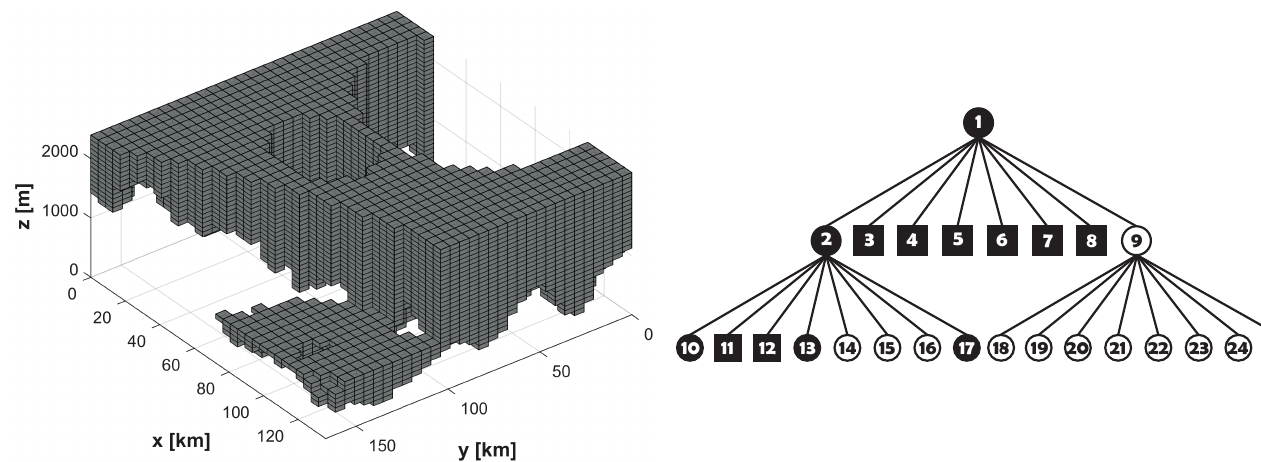
Figure 3. Total free 3D space calculated using the adaptive cell decomposition (ACD) algorithm with a decomposition level of i = 5 ( left ) and a tree scheme of a hypothetical Octree block ( right